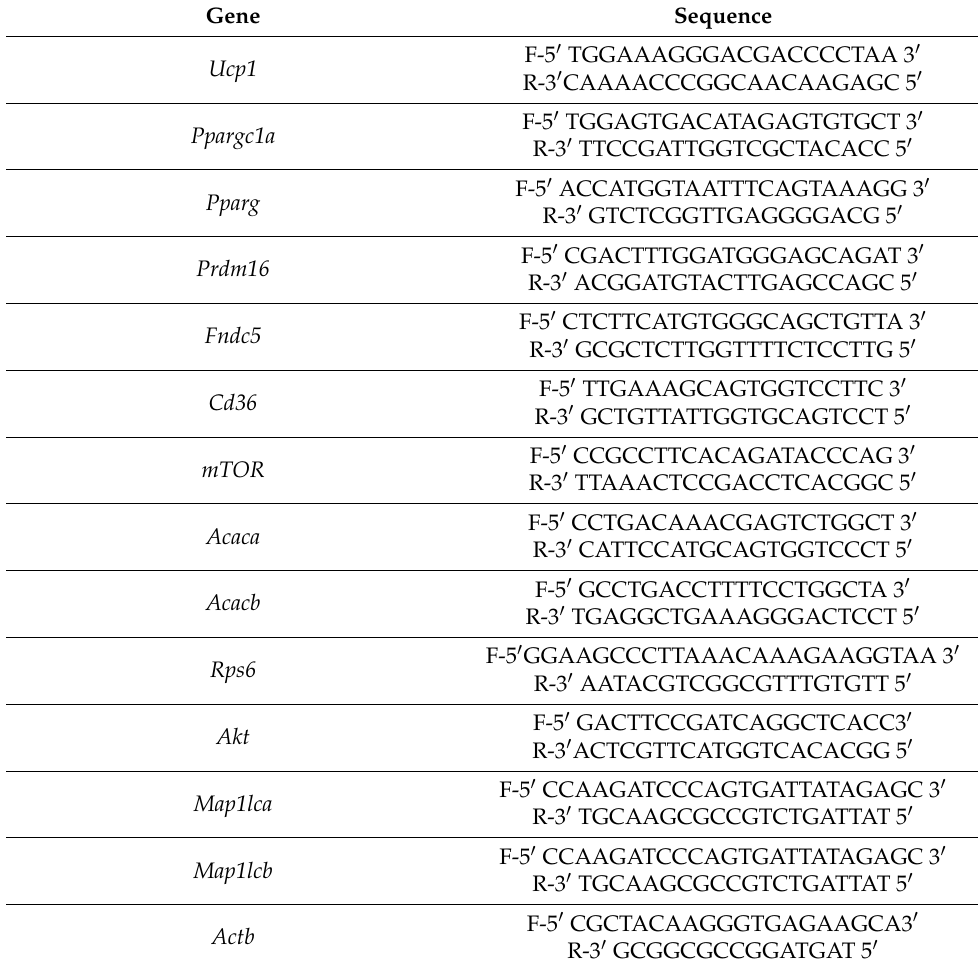
Table 1. Primer sequences used for quantitative